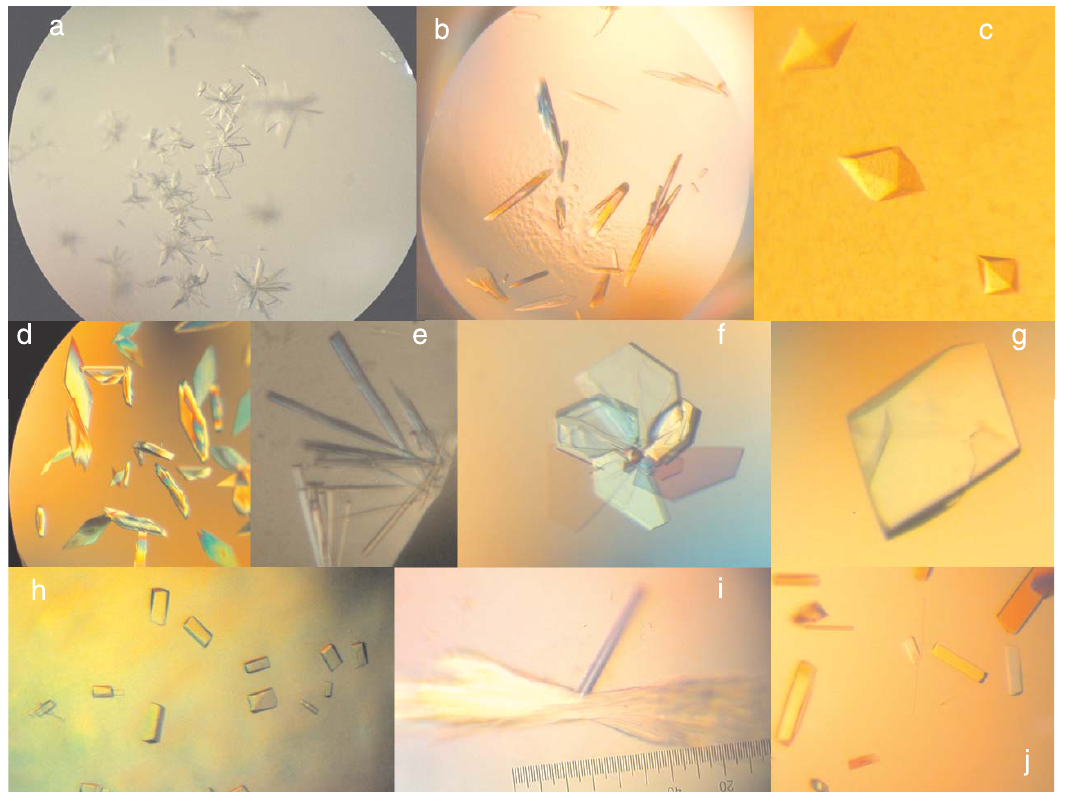
Fig. 2 – Crystals obtained by four different groups of the SMolBNet. The letters “ a” to “ j” correlate to the information for each individual protein presented in Table I. Their sizes vary approximately from a few µ m to one